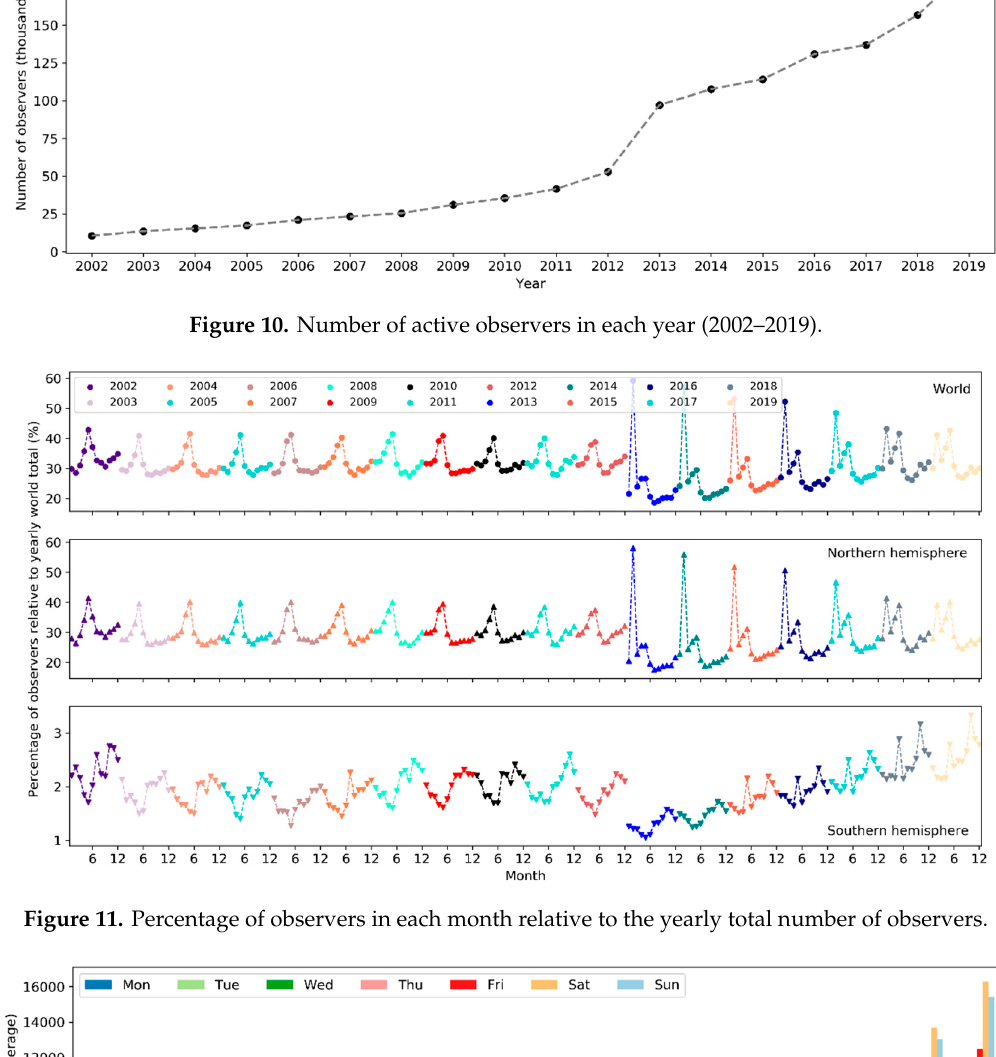
Figure 9. The cumulative number of observers as of 31 December 2019 mapped over 0.25° latitude × 0.25° longitude grid cells. Intervals were determined loosely following quartile classification method.